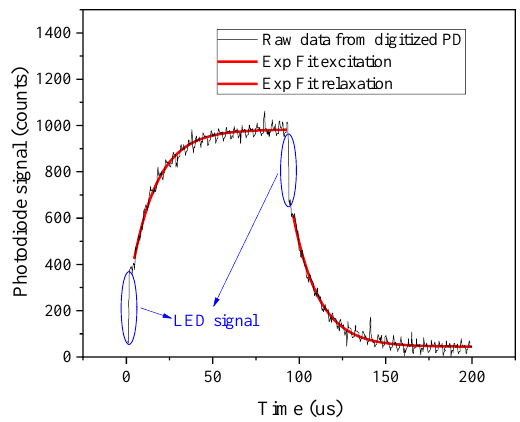
Figure 6. Digital converted photodiode raw data response of a complete measurement transient, PtTFPP/PSF luminophor. Exponential fitting is superimposed (red line) and residual LED signal are highlighted (blue